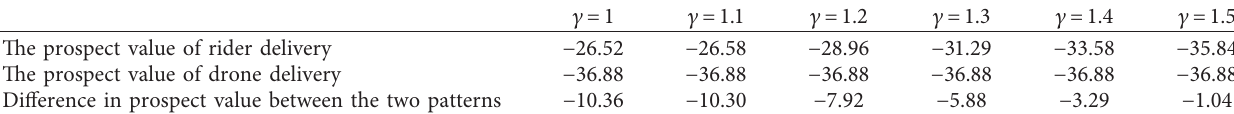
Table 6: T � 5, δ � 1.5, and L � 5. The comparison of the prospect value of the two delivery patterns under different delay coefficients.